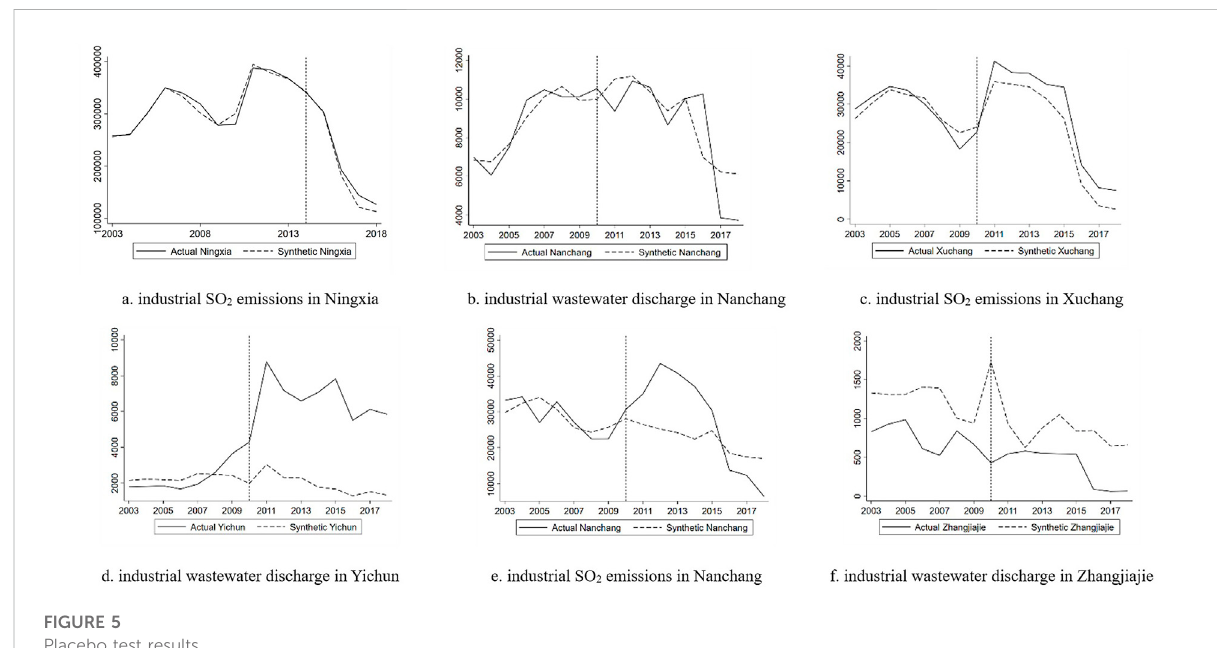
FIGURE 5 Placebo test results.